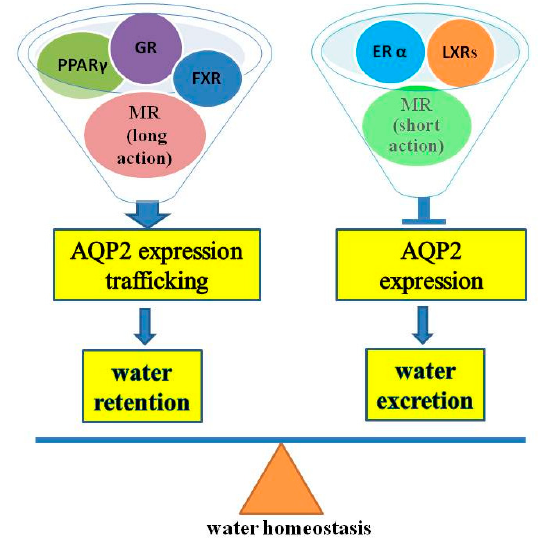
Figure 3. NRs in controlling AQP2 gene expression and function.